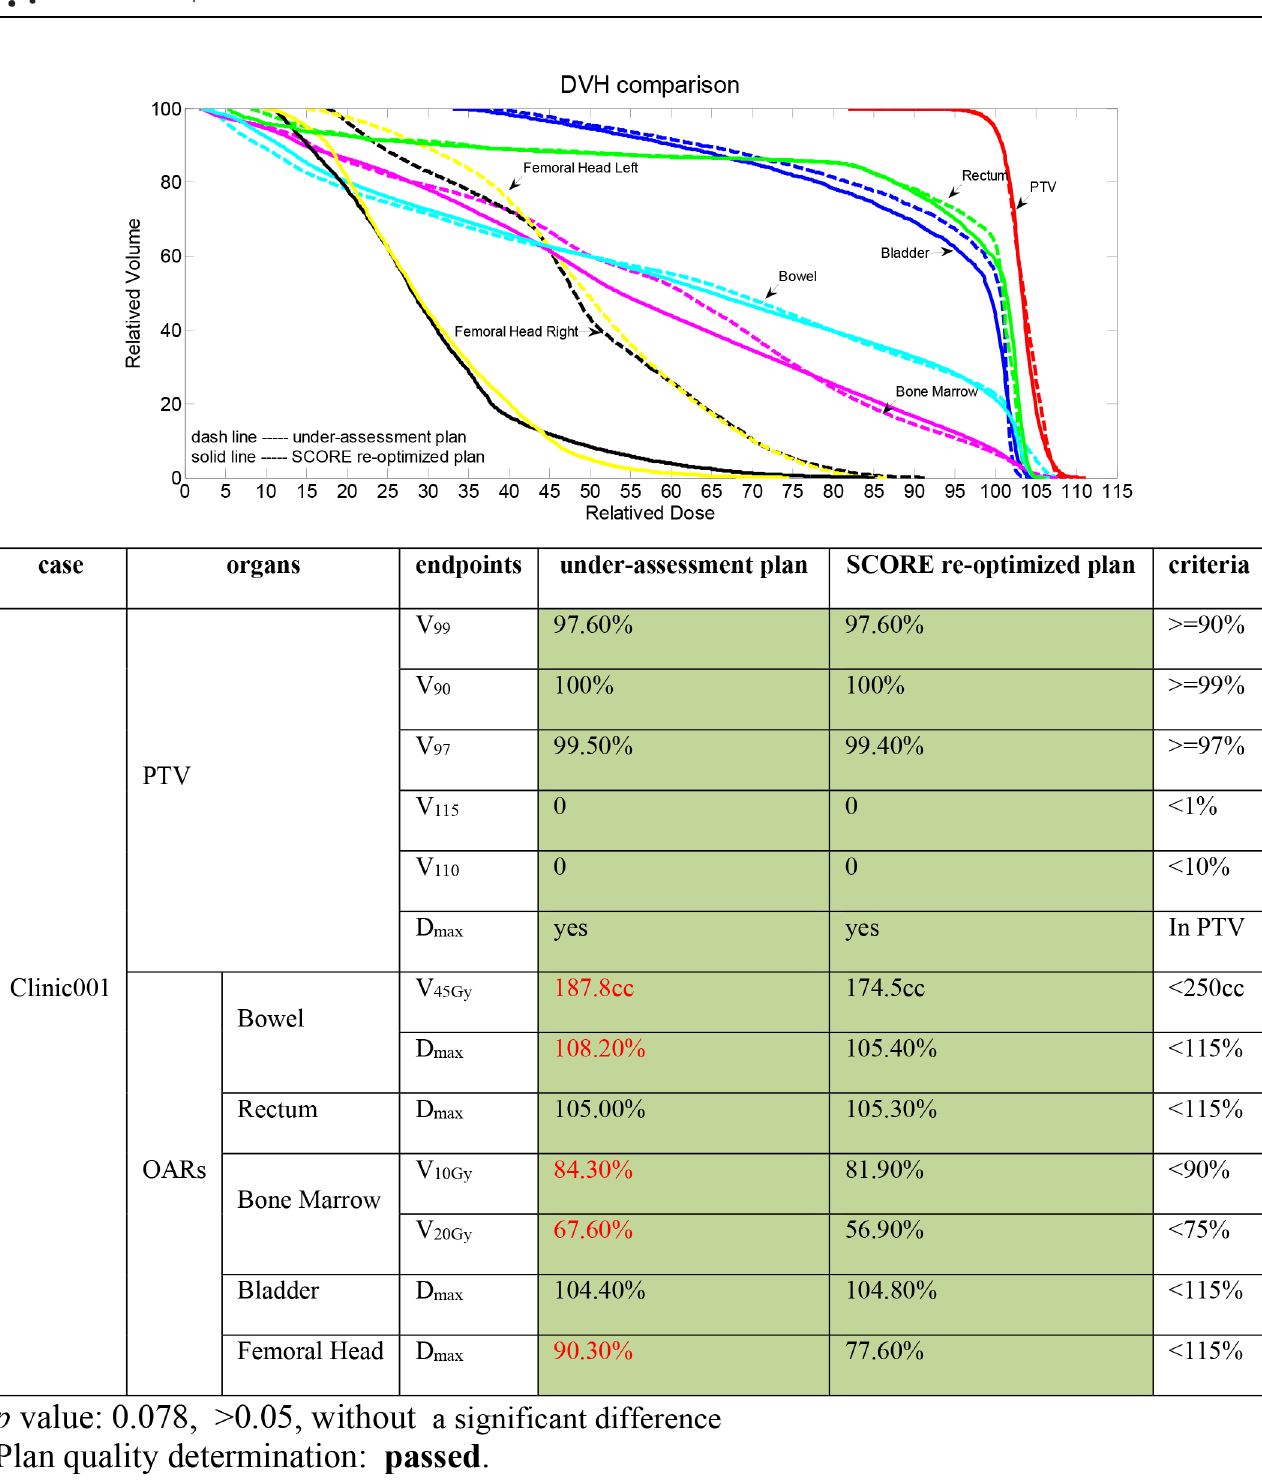
Fig 2. A QC report example for one clinically approved cervical cancer IMRT